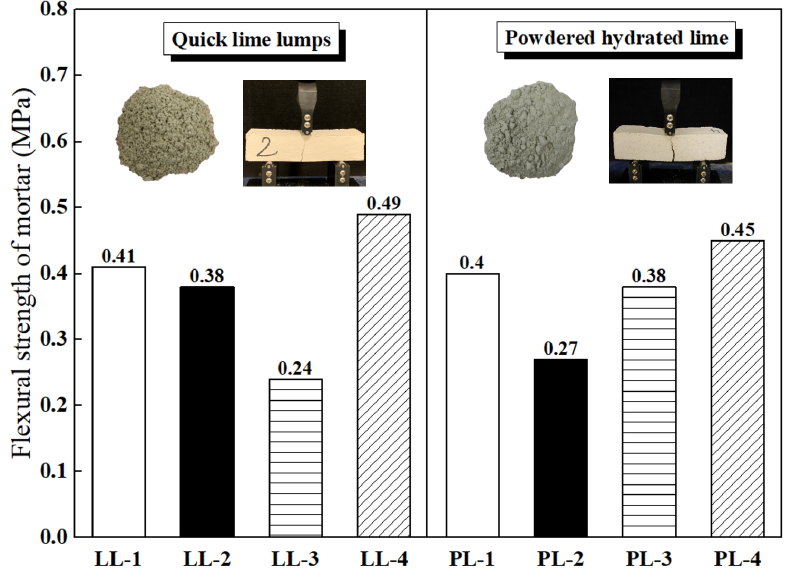
Figure 13. Flexural strength of mortar at 56 days.